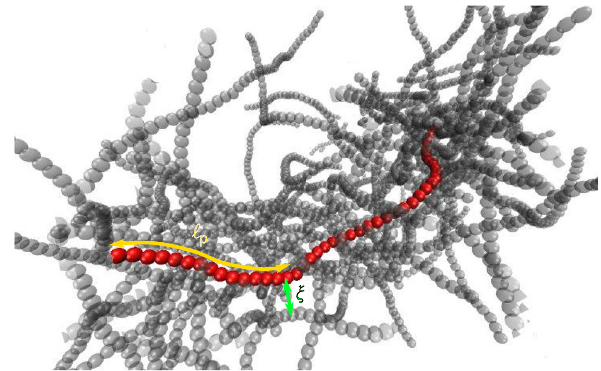
Fig. 1 Illustration of an entangled polymer solution. Typical con fi guration of a tracer fi lament (red) with persistence length ‘ p = L ¼ 0 : 44 in an entangled solution with relative mesh size ξ / L = 0.1. For better visibility of the surrounding chains (grey), only those in direct proximity to the tracer fi lament are shown. The dynamics of an entangled solution on different time scales is illustrated in Supplementary Movie